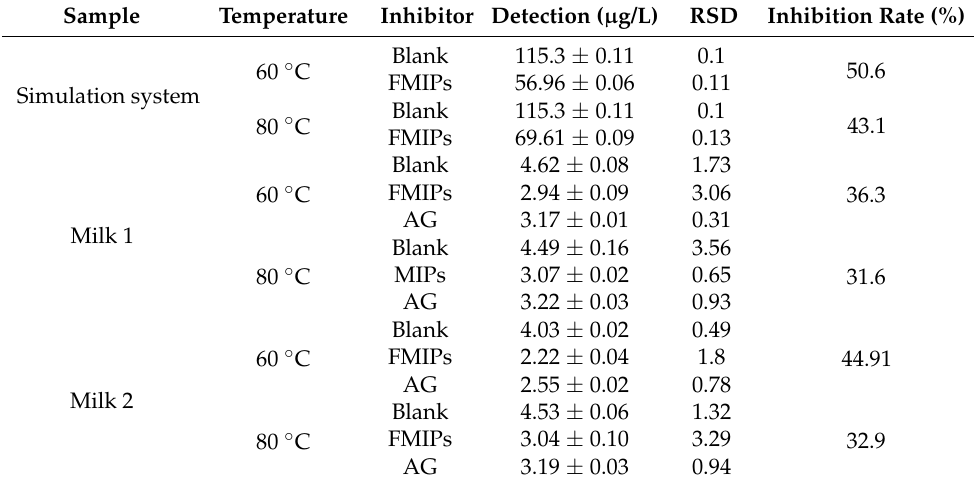
Table 1. Determination of PRL in simulation system and milk samples by